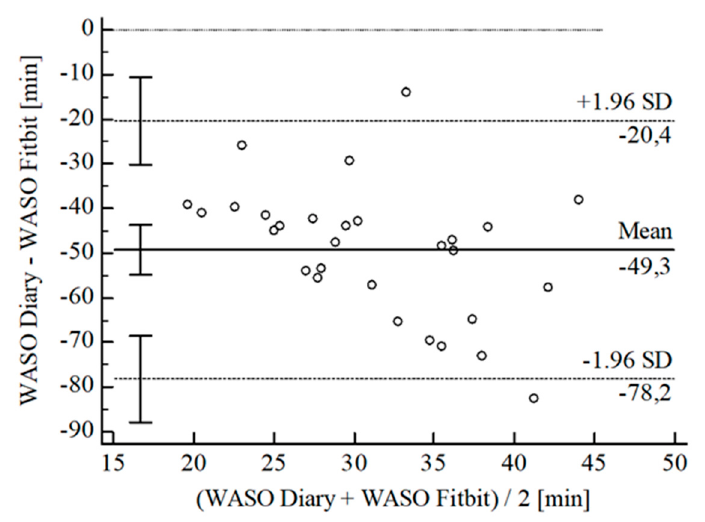
Figure 11. Bland-Altman plot for SE Polar ® vs. diary.